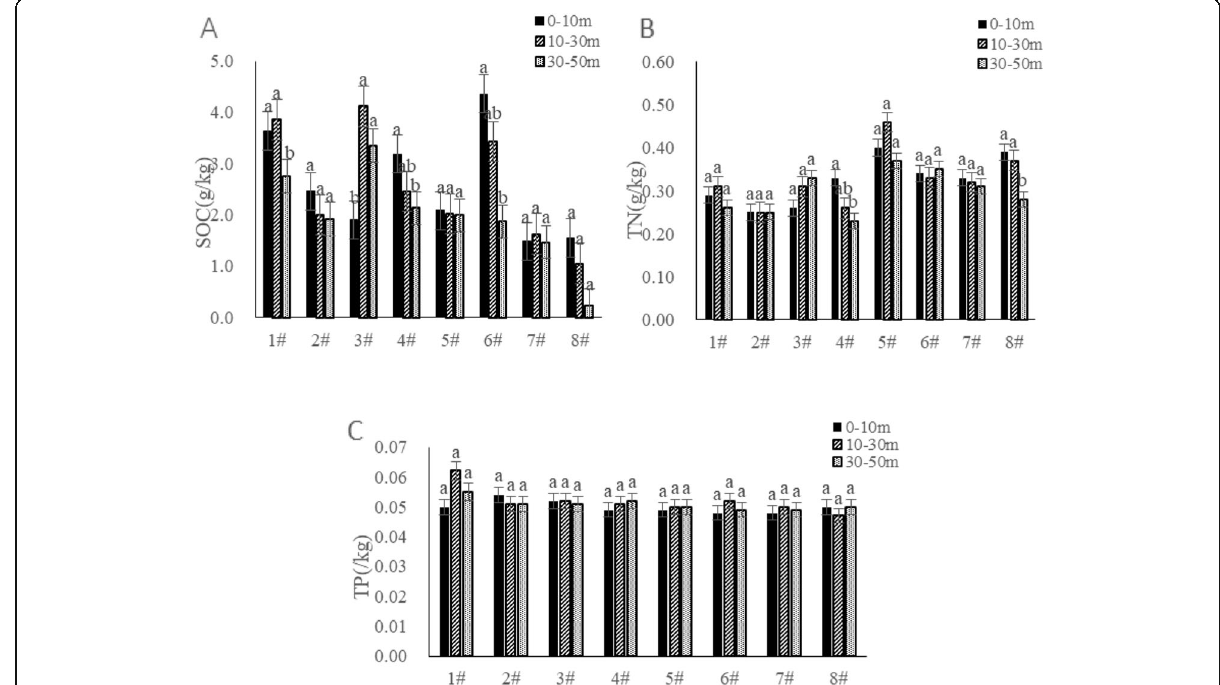
Fig. 2 Distribution characteristics of soil essential nutrients in different regions of oil well